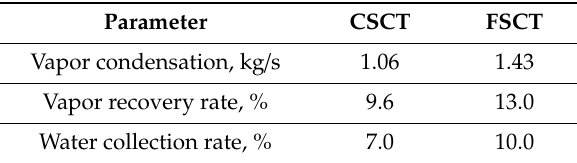
Table 4. Calculated Parameters of the CSCT and FSCT.